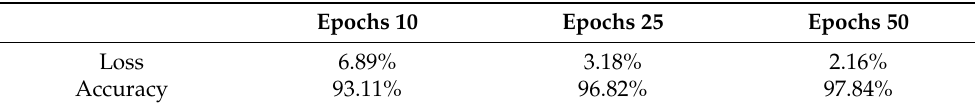
Table 2. Training accuracy and validation loss for transfer learning-based model, trained on augmented MRIs.